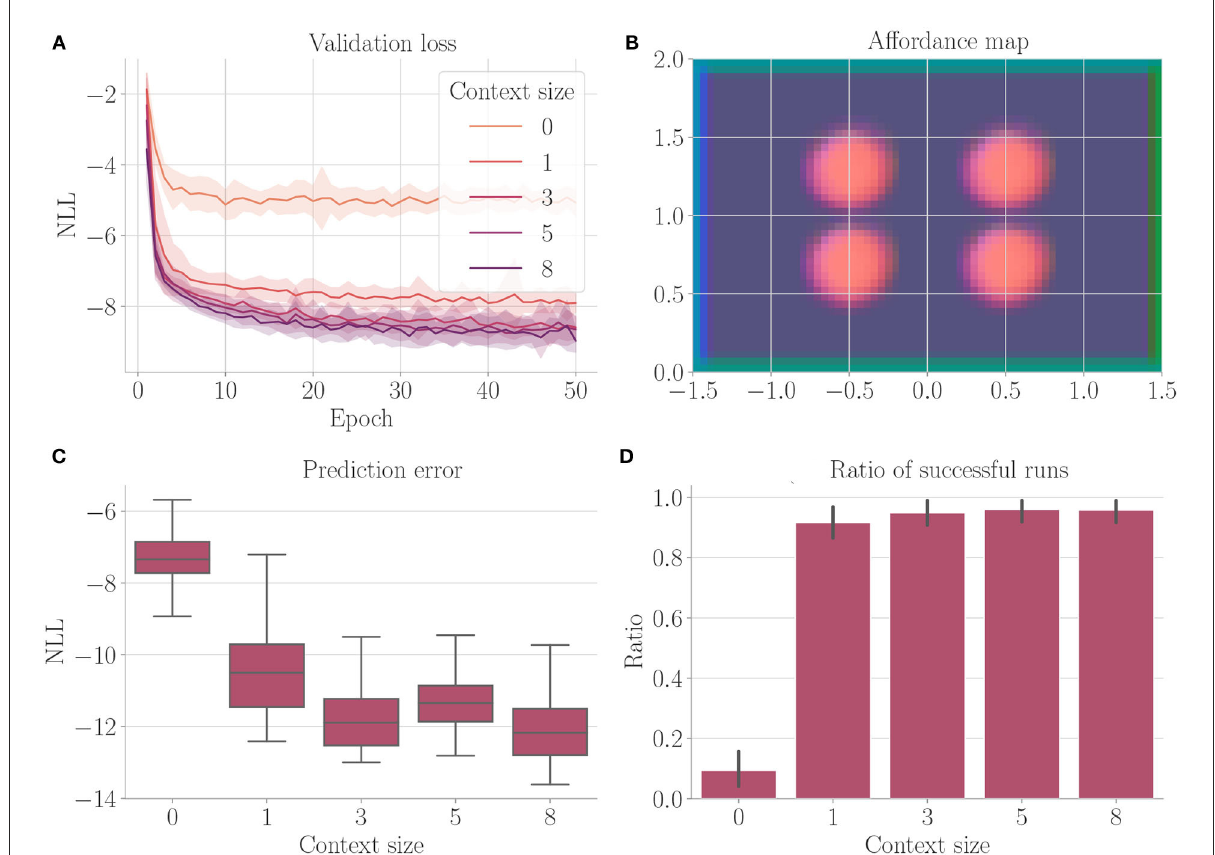
FIGURE10 Results from Experiment IV–Uncertainty avoidance (Section 4.6). For each setting, the results are aggregated over 25 differently initialized models which each performed 4 goal-directed control runs for 200 time steps. The box plot shows the medians (horizontal bars), quartiles (boxes), and minima and maxima (whiskers). Data points outside of the range defined by extending the quartiles by 1.5 times the interquartile range in both directions are ignored. The bar plots show the means, where black lines represent the SDs. (A) Validation loss during training. It is the negative log-likelihood of the actual change in position in the transition model’s predicted probability distribution. Shaded areas represent SDs. (B) Exemplary affordance map for context size 8 . To generate this map, we probed the environmental map at every sensible location, applied the vision model to each output, performed dimensionality reduction to 3 via PCA, and interpreted the results as RGB values. (C) Prediction error during goal-directed control. It is the negative log-likelihood of the actual change in position in the transition model’s predicted probability distribution. (D) The ratio of successful runs. A run was successful if the agent was closer to the target than 0.1 units in at least one time step and did not touch fog in any time